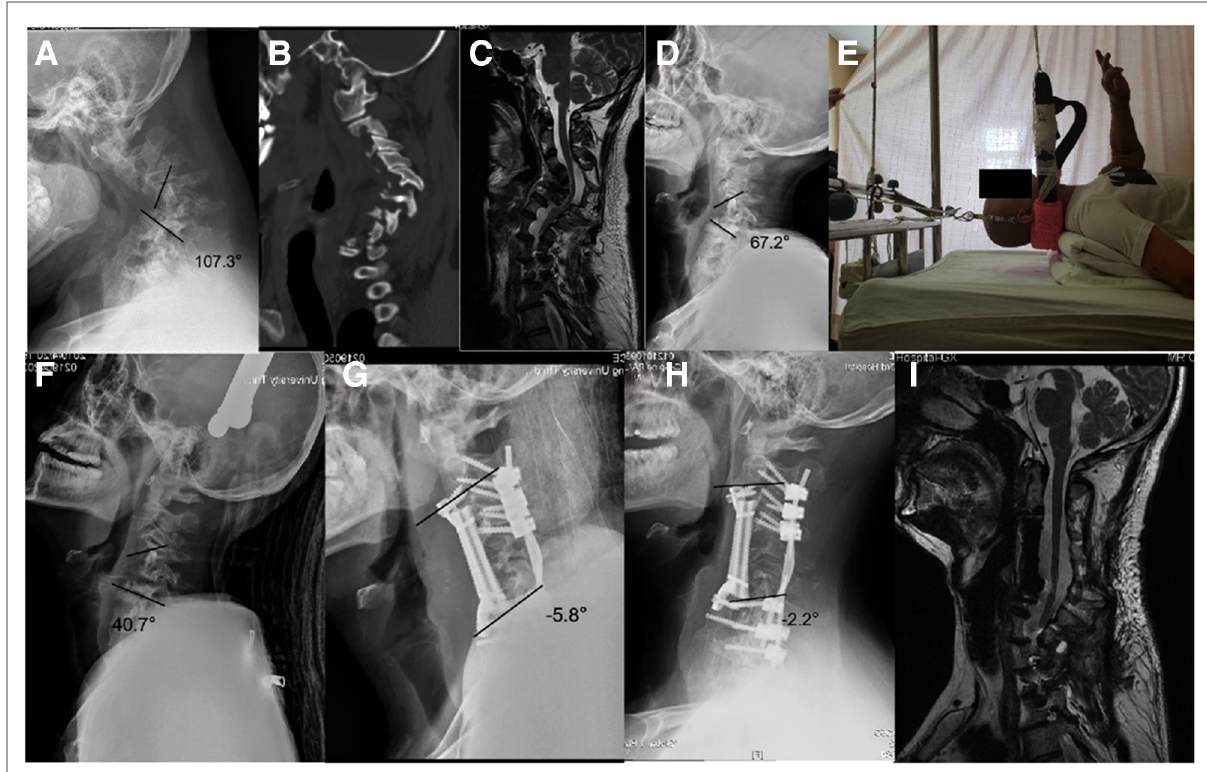
FIGURE 3 Case 3. A 44-year-old patient with severe NF-1 cervical kyphosis had tetraplegia after an unexpected fall. Pre-operative mJOA score was 10. ( A ) Pre- operative x-ray revealed a C3 – 7 Cobb angle of 107.3° before traction. ( B ) A para-sagittal computed tomography (CT) reconstruction showed no facet joint fusion. ( C ) Sagittal magnetic resonance imaging (MRI) showed severe compression of spinal cord at C3 – 6 level. ( D ) After one week suspensory traction, the Cobb angle had reduced to 67.2° with a correction rate of 37.4%. ( E ) 12 days combined traction. ( F ) After 12 days combined traction, the Cobb angle had improved to 40.7° with a correction rate of 62.1%. ( G ) Post-operative x-ray showed the Cobb angle reduced to − 5.8°. ( H ) x-ray at 2 years showed no loss of correction. ( I ) MRI showed completed decompression of cervical spinal cord with mJOA score improved from 10 to 14.5 post-operatively.